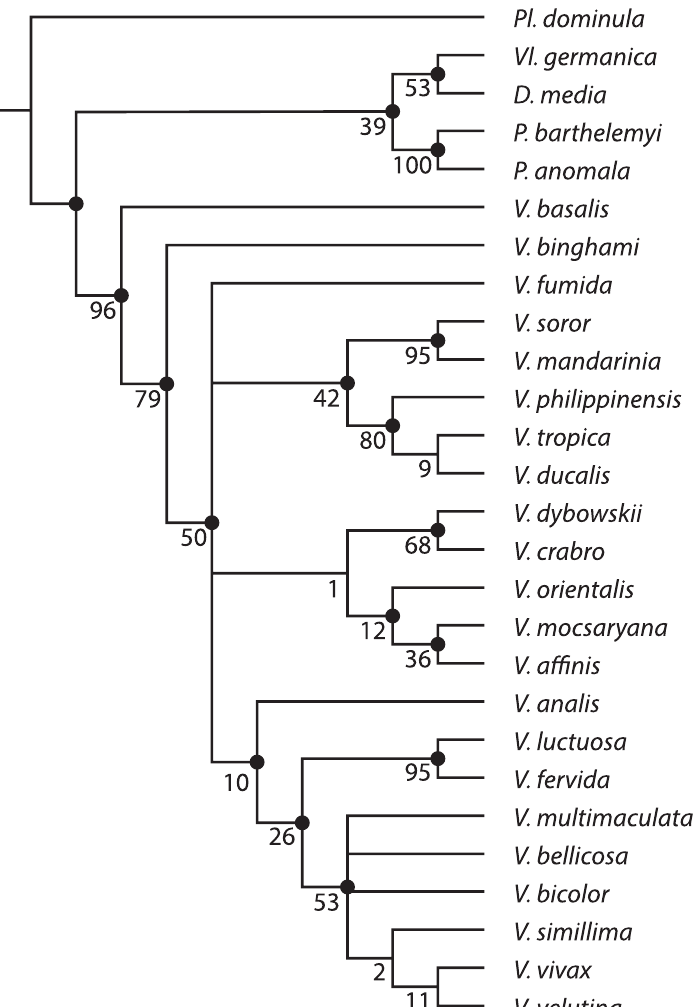
Figure 4. Support tree for the relationships within the genus Vespa based on a combined analysis. Sup- port tree based on 45 morphological characters and six genes. Black nodes indicate clades supported by morphological characters. Absence of mark on nodes indicates clades diagnosed by molecular data only. Supports for nodes are given in